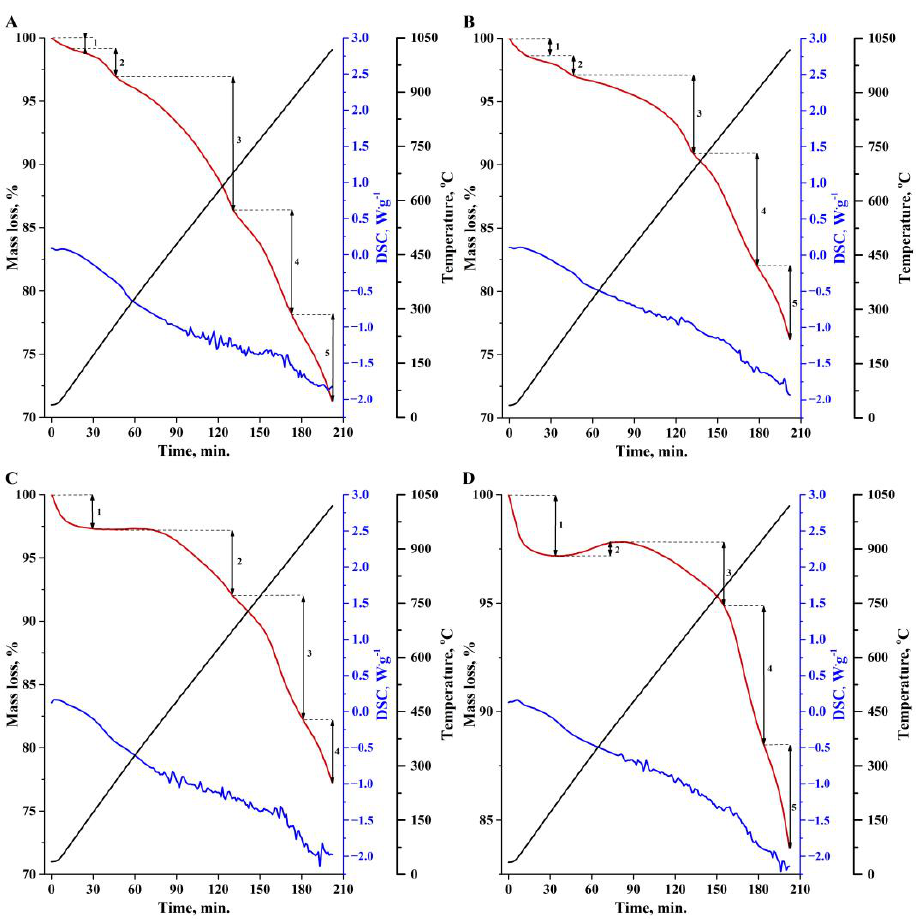
Figure 8. TGA-DTA analysis results of SSB1 ( A ), SSB4 ( B ), SSB5 ( C ) and SSB6 ( D ); ( − ) TGA, ( − ) DTA, ( − ) Temperature.